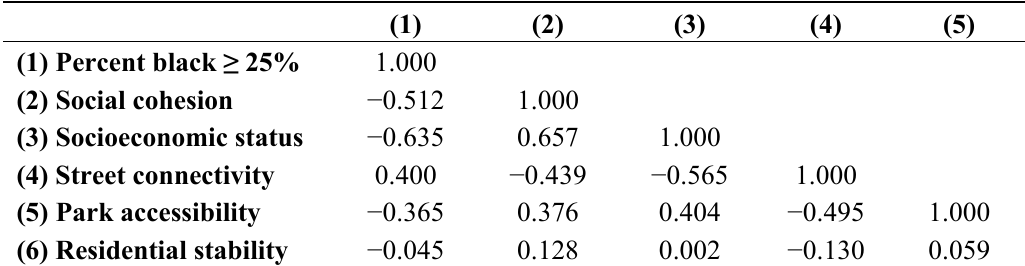
Table 2. Correlation matrix between neighborhood-level